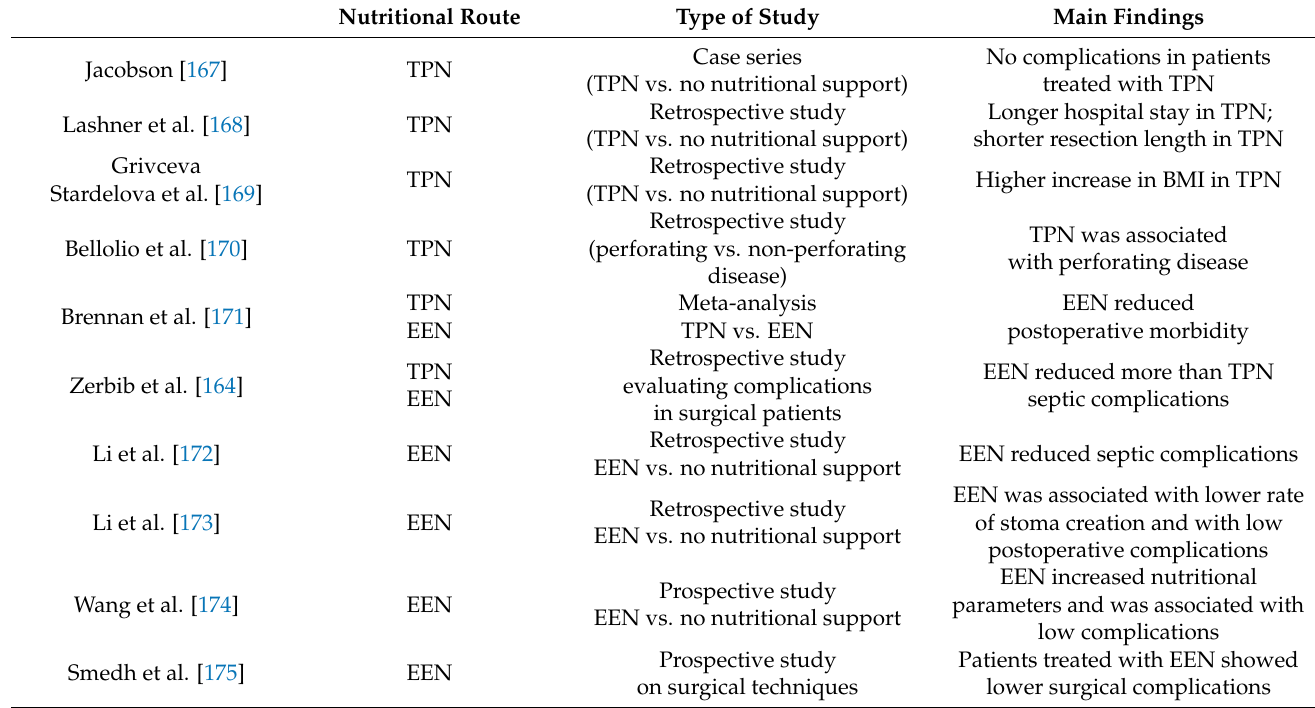
Table 2. The main studies evaluating nutritional support in surgical patients with